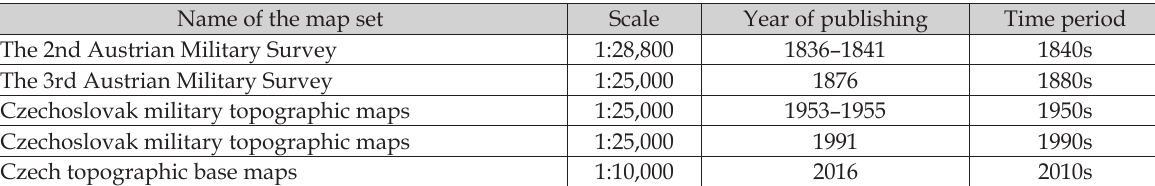
Table 1. Topographic maps covering the Hodonín